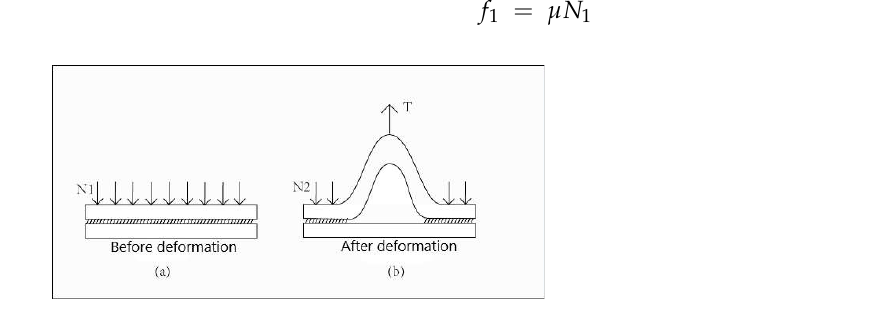
Figure 1. The deformation diagram of displacement amplitude of the plate under the force.